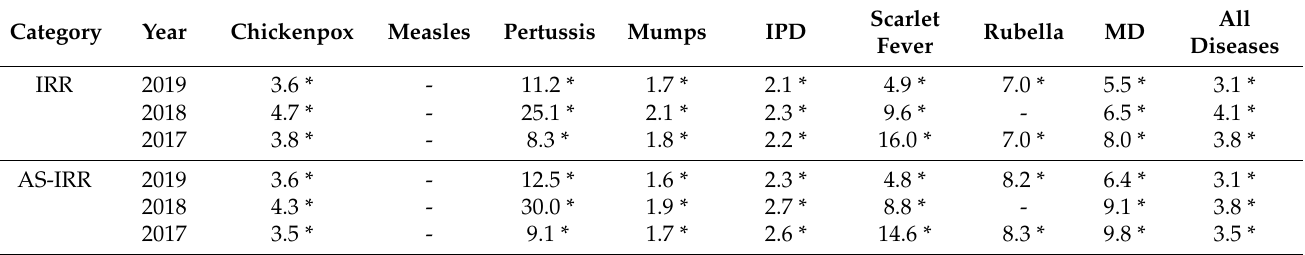
Table 3. Yearly IRRs and AS-IRRs for eight infectious respiratory